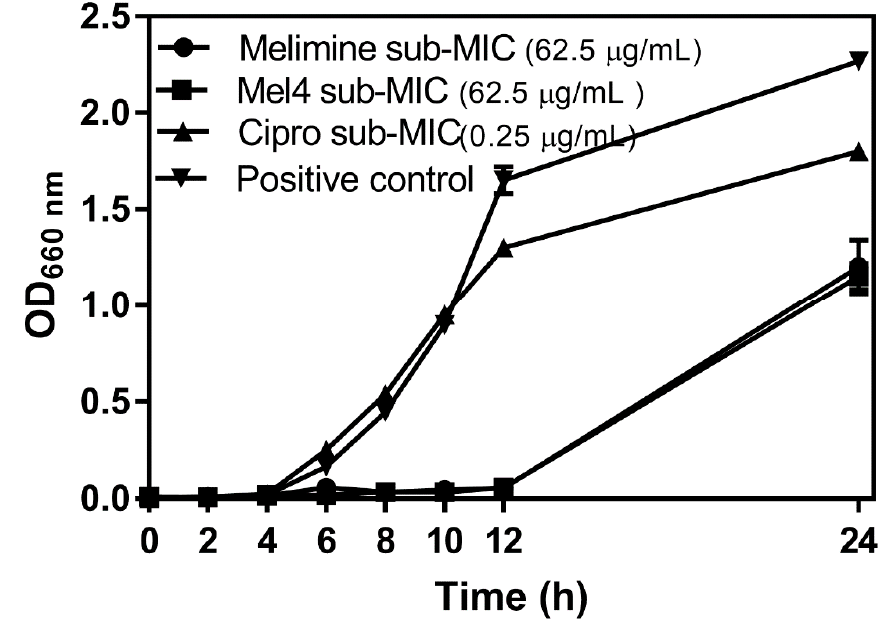
Figure 1. Growth curves for P. aeruginosa ATCC 27853 at sub-MIC of the antimicrobial peptides (AMPs) melimine and Mel4 or ciprofloxacin (Cipro). The positive control was growth in the absence of any antimicrobial.